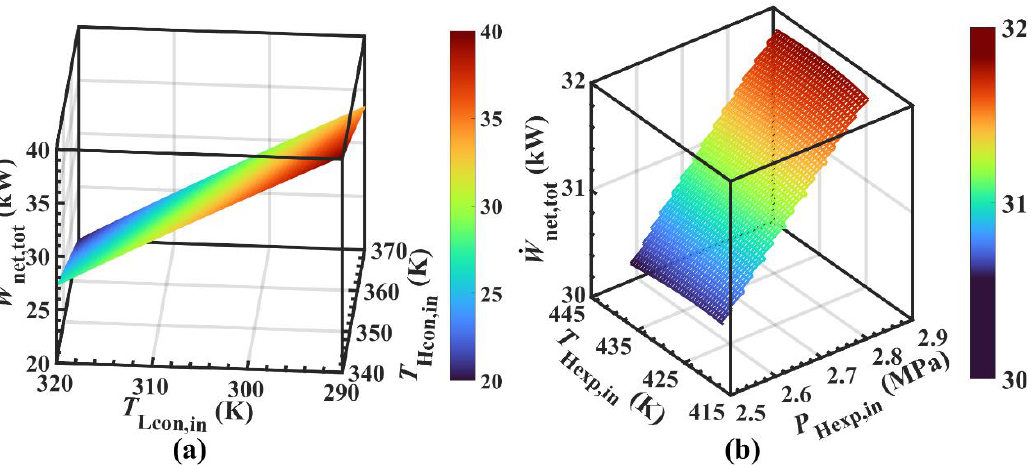
Figure 7. Influence characteristics of key variables on system power output. ( a ) Effect characteristics of inlet temperature of a condenser on the system power in a different cycle. ( b ) Effect characteristics of parameter of expander on system power in HT cycle.